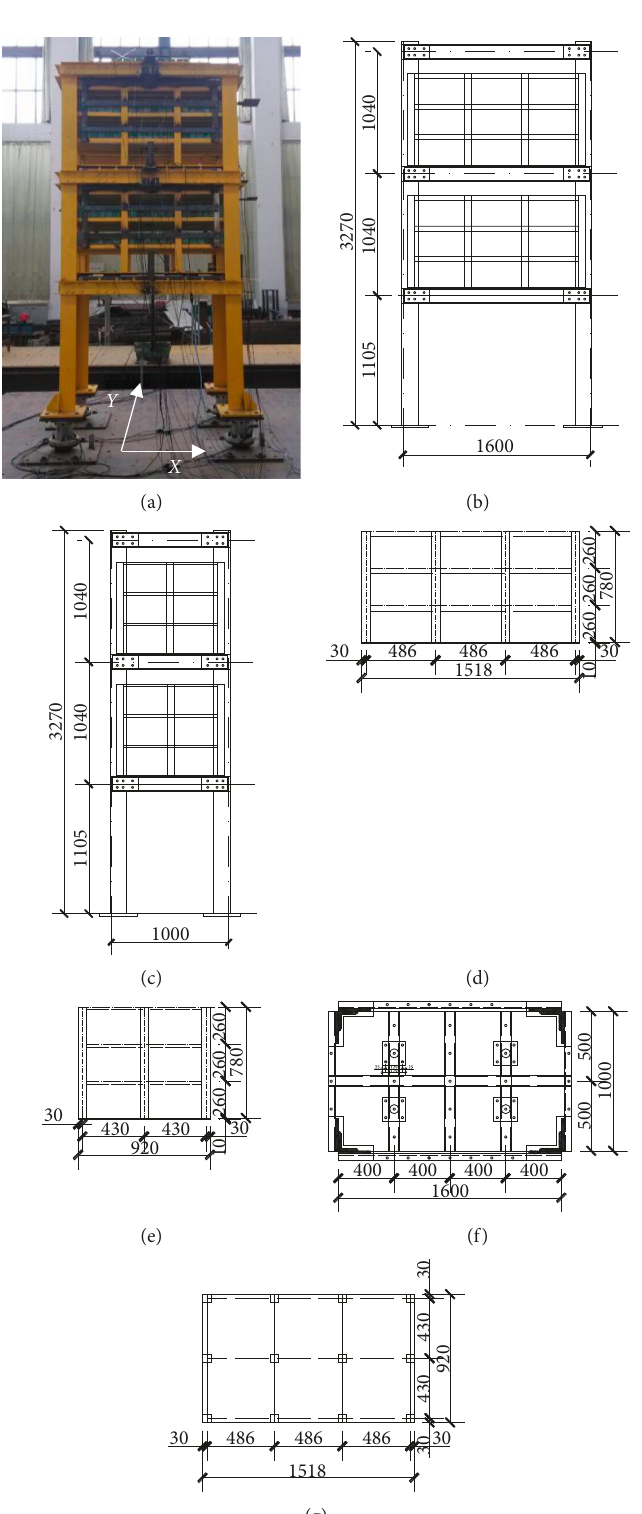
Figure 1: Mega-substructure model. (a) Picture of the mega-substructure, (b) front elevation of the mega-substructure, (c) side elevation of the mega-substructure, (d) front elevation of the subframe, (e) side elevation of the subframe, (f) plan of the main frame, and (g) plan of the